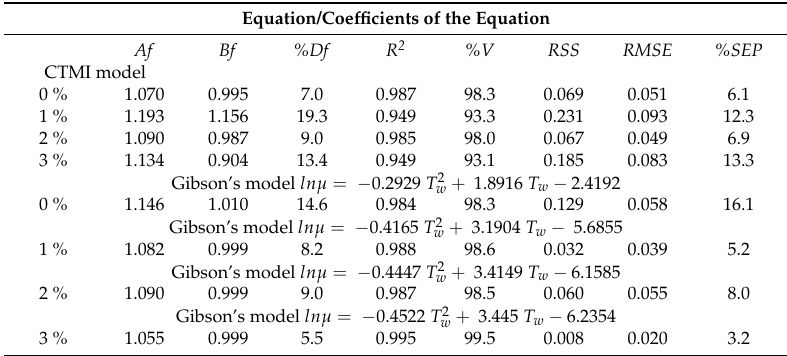
Table 3. The equations of Gibson’s model, the coefficients of the CTMI model and the indices of the internal validation for Fresco culture